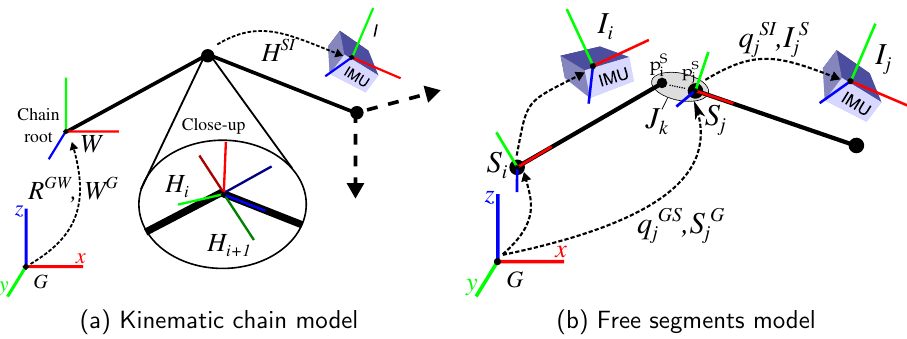
Figure 1. Two different biomechanical model representations. Note the additional world coordinate system in the kinematic chain